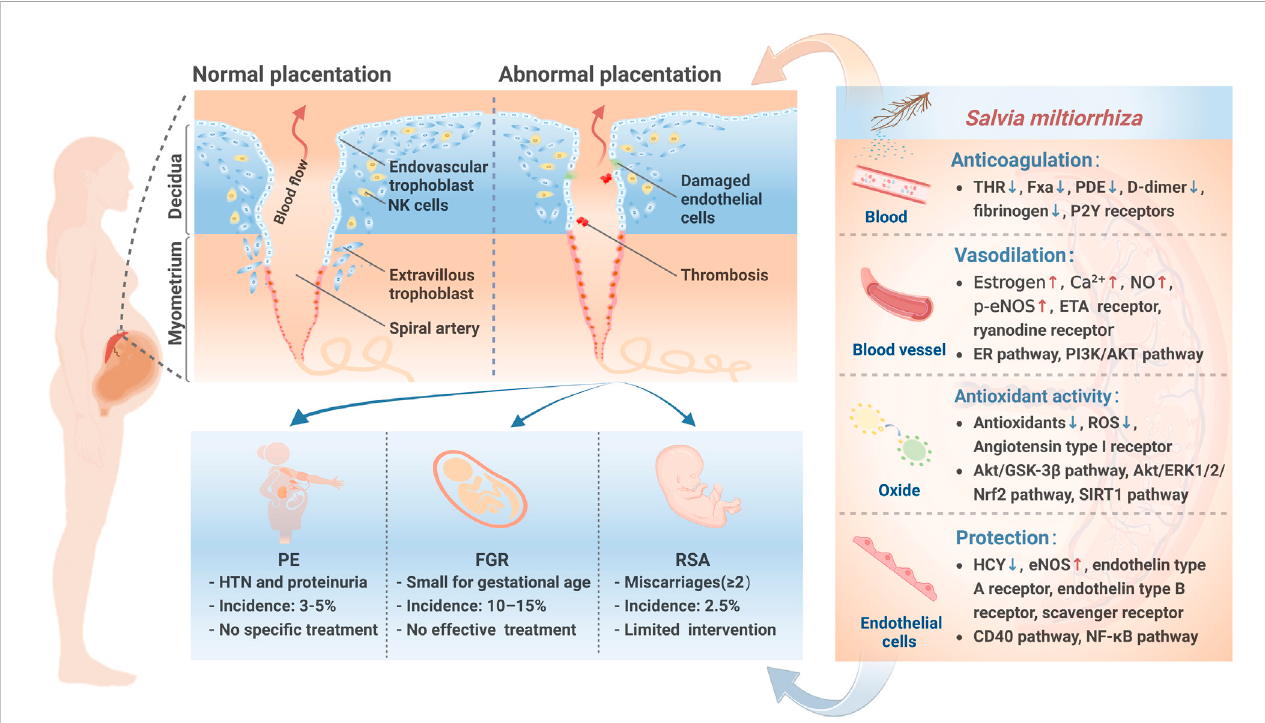
FIGURE 1 PMPCs pathophysiology and the mechanisms of S. miltiorrhiza in PMPCs. During normal placentation, extravillous cytotrophoblasts invade the uterine spiral arteries of the decidua andmyometrium, transforming the spiral arteries into large-caliber vessels. However, during abnormal placentation in PMPCs, failed spiral artery remodeling constrains maternal-fetal interface blood fl ow, which contributes to the pathogenesis of PMPCs. NK, natural killer; PE, preeclampsia; FGR,fetalgrowthrestriction;RSA,recurrentspontaneousabortion;HTN,hypertension;THR,thrombin;Fxa,factorXa;NO,nitricoxide;p- eNOS, phosnhorylation of endothelial nitric oxide synthase; ETA, endothelin A; ROS, reactive oxygen species; HCY, homocysteine.